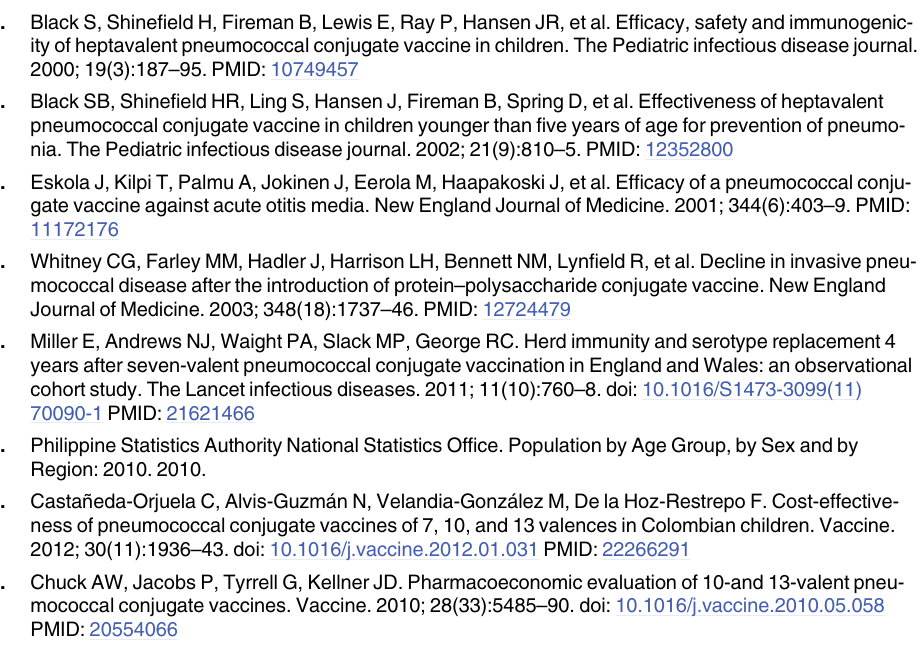
S1 Table. Philippine vaccine-type IPD coverage of PCV7, PCV10, and PCV13 in different age groups. S2 Table. Summary of % reduction in IPD and Pneumonia incidences in the Philippines (PHL) based on US